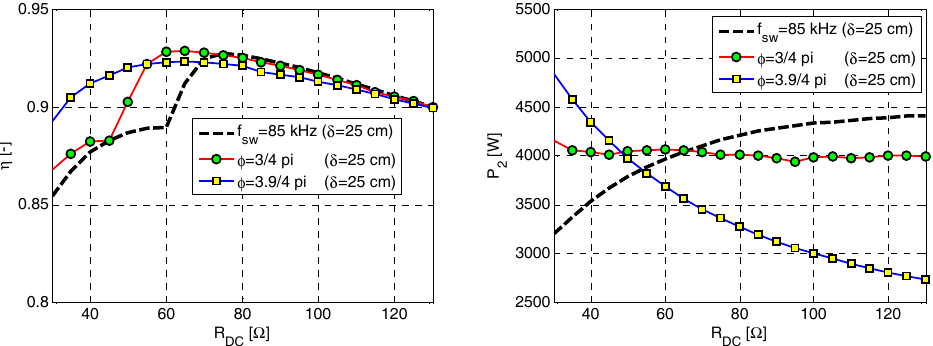
Figure 15. Efficiency ( left ) and power delivered to the load ( right ) during phase-shift control and fixed switching frequency operation—operational distance 25 cm.